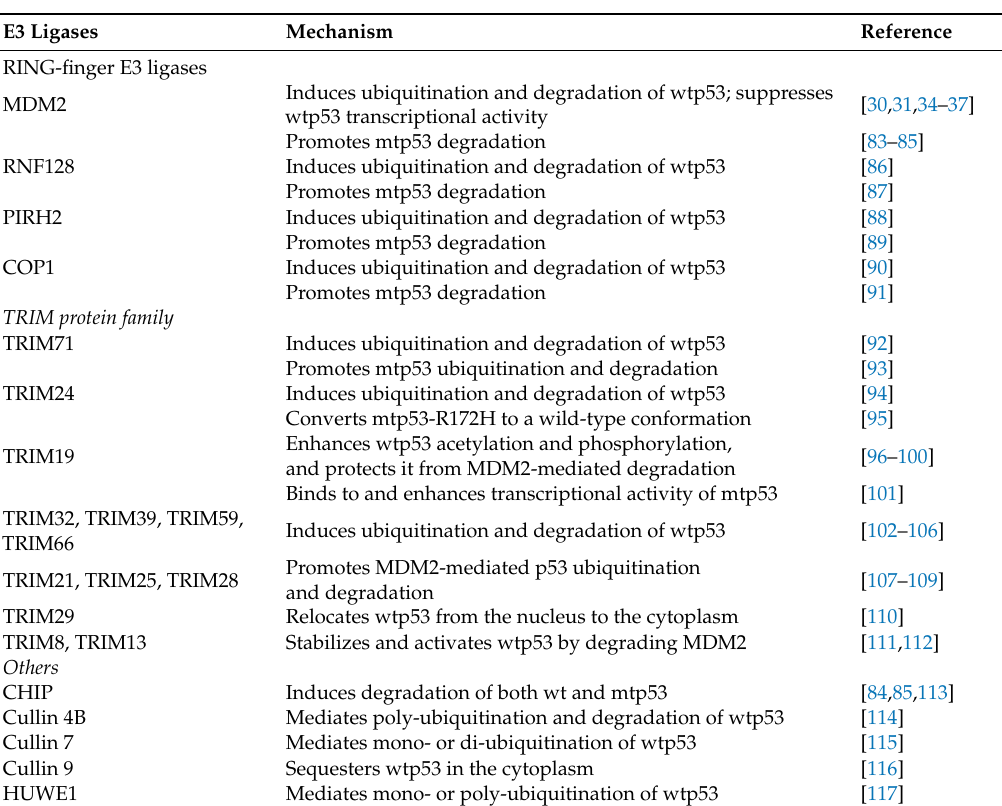
Table 1. Wild-type / mutant p53-targeting E3 ligases in